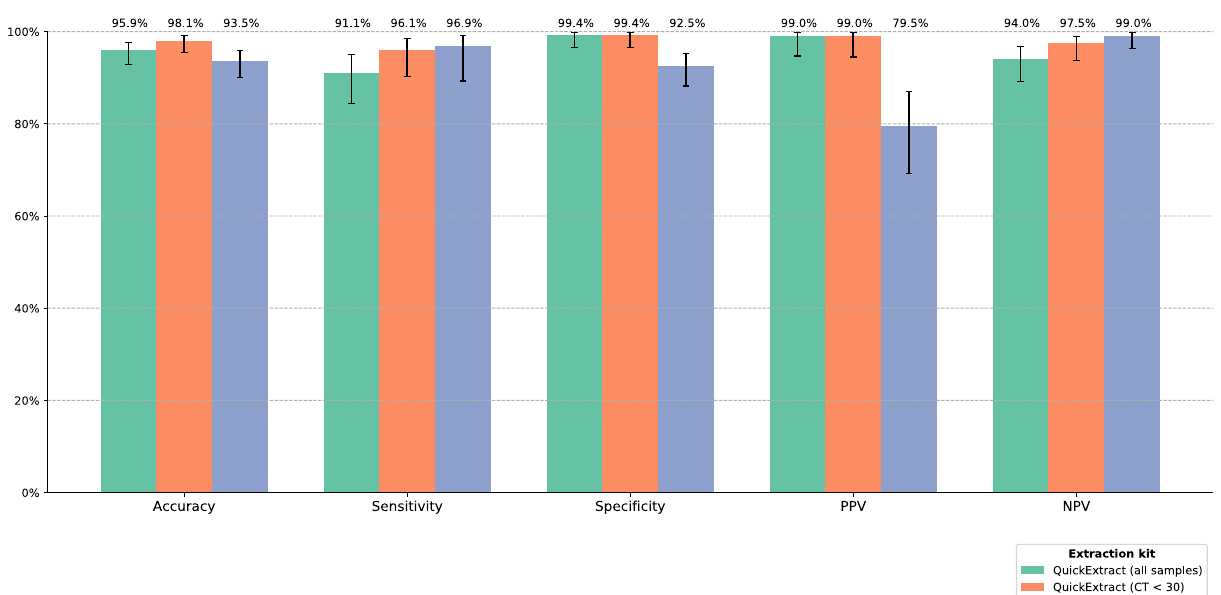
Figure 2. Performance results for the NGS approach in three different scenarios: (1) One-step RNA extraction using QuickExtract for all samples; (2) One-step RNA extraction using QuickExtract for samples with CT values lower than 30; (3) Regular ThermoFisher kit RNA extraction using MagMAX Viral/Pathogen II Nucleic Acid Isolation Kit. Error bars indicate 95% confidence intervals for the binomial proportions, calculated using Wilson score interval.